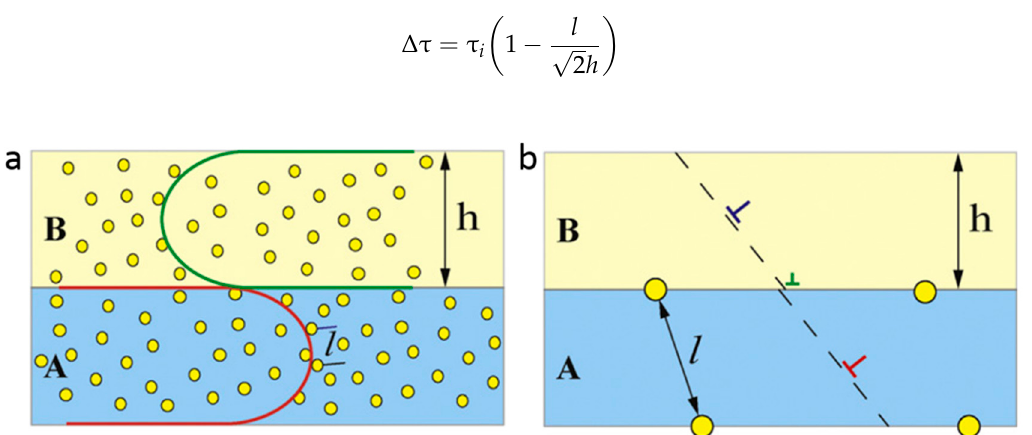
Figure 18. Schematic illustration of dislocation-He bubble interactions in multilayers with various layer thicknesses: ( a ) for large layer thickness, CLS is the dominant deformation mechanism and He bubbles serve as obstacles for dislocations; and ( b ) for small layer thickness, dislocation crossing is the main deformation mechanism and He bubbles on interfaces have a less significant effect on dislocation behavior. Reprinted with permission from [106]; Copyright 2011 Elsevier.